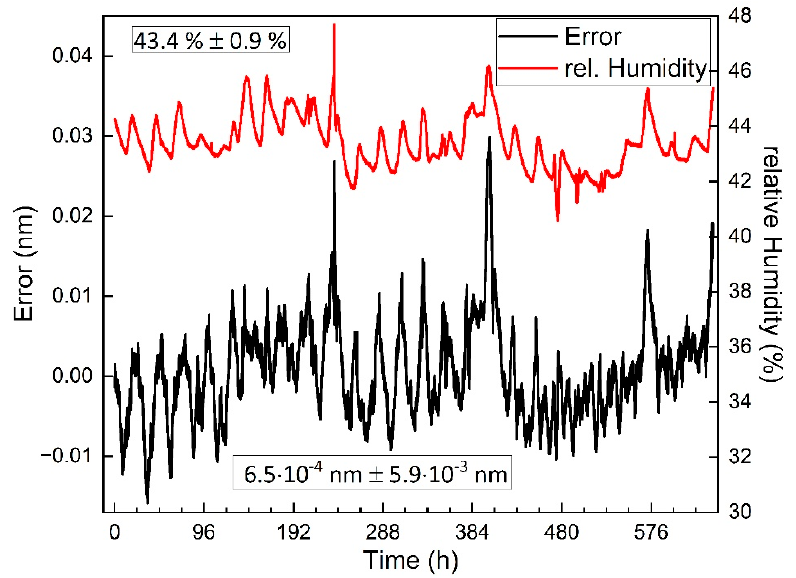
Figure 8. Difference between AWG and OSA signal together with the relative humidity. The largest errors occur when there are great variations in the humidity.